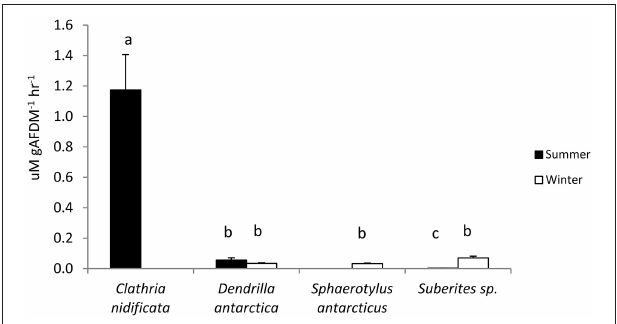
FIGURE 4 | Urea production by sponges in summer and winter. Values of urea production with the same letter are not significantly different (Tukey tests, P < 0.05 ).